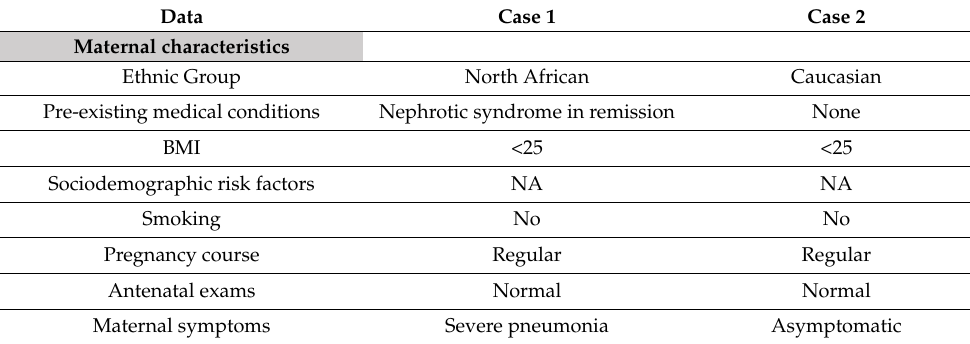
Table 1. Maternal and neonatal data of the two